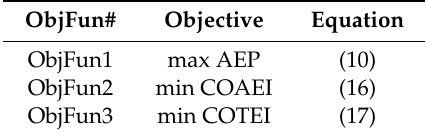
Table 2. Definition of the three objective functions.